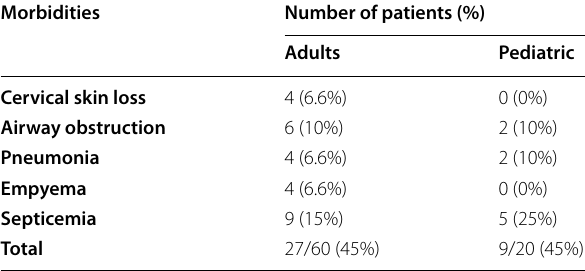
Table 4 Morbidities after the DNSI